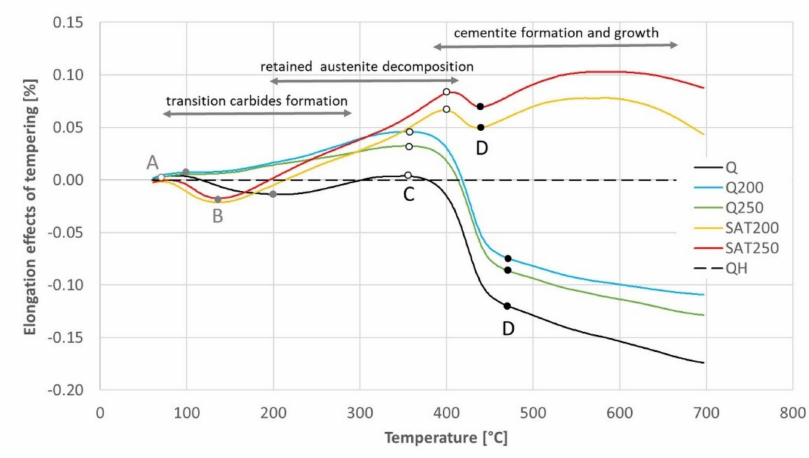
Figure 13. The difference in elongation between the sample without any transformation and other samples tempered with continuous heating. Points A, B, C and D were input data for Table 7. Table 7. The differences in elongation read from Figure 13 at points before the main effects of transition carbides formation (column A), retained austenite decomposition (B), cementite precipitation (C) and just above the main effect of cementite precipitation (D). The differences associated with the transformations are calculated in the columns between the